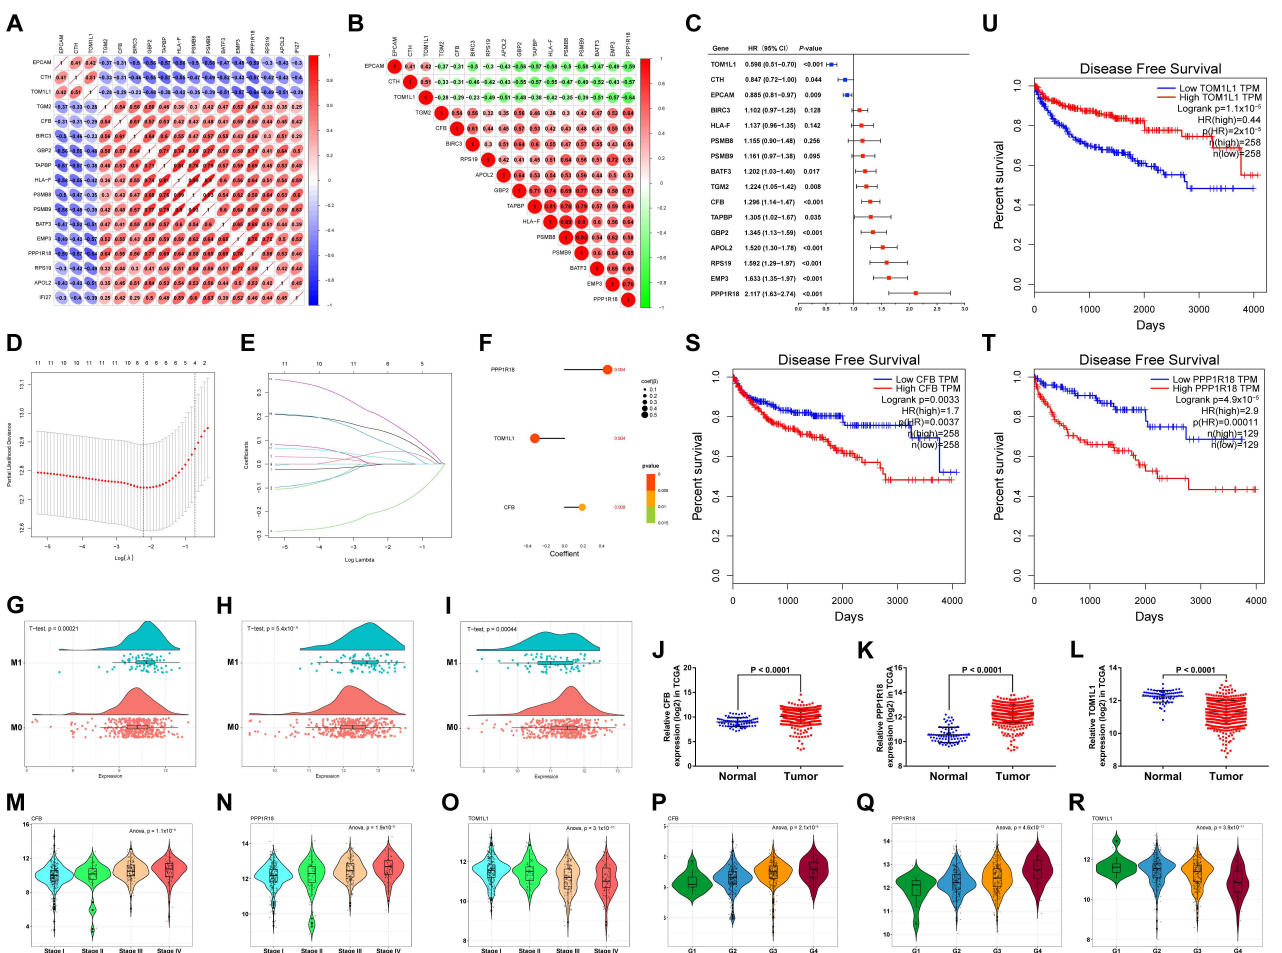
Figure 7. Identification and validation of the DMA-RMSGs that independently predict ccRCC prognosis. ( A ) Heat map of the correlations among the 17 DMA-RMSGs. ( B ) Heat map of the relation- ship among the 16 key DMA-RMSGs. ( C ) Univariate Cox regression analysis of the DMA-RMSGs. ( D , E ) LASSO regression analysis of the TCGA cohort. ( F ) Multivariate Cox regression analysis identified the coefficient of the three key DMA-RMSGs. Raincloud plots display the significantly distinct expression levels of CFB ( G ), PPP1R18 ( H ), and TOM1L1 ( I ) between nondistant and distant metastasis samples ( p < 0.001). The independent expression patterns of CFB ( J ), PPP1R18 ( K ), and TOM1L1 ( L ) between normal and tumor tissues. The expression levels of CFB ( M ), PPP1R18 ( N ), and TOM1L1 ( O ) were significantly associated with the pathological stage ( p < 0.001).